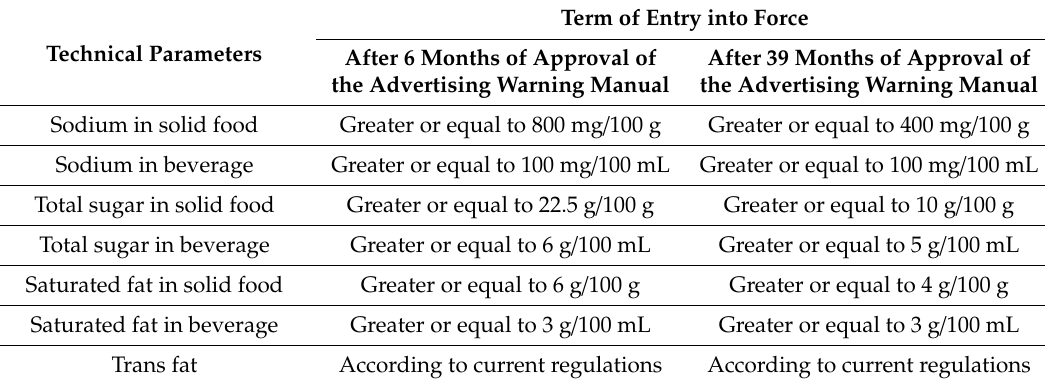
Table 1. Technical parameters and entry into force of the Peruvian